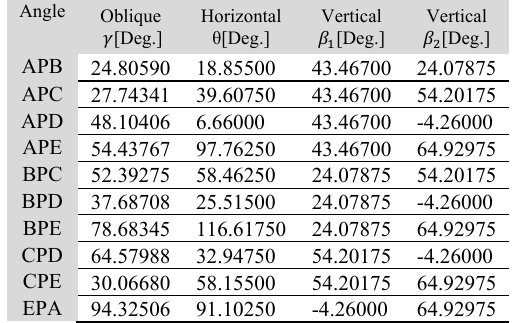
Table 4. Derived angles of the second test.